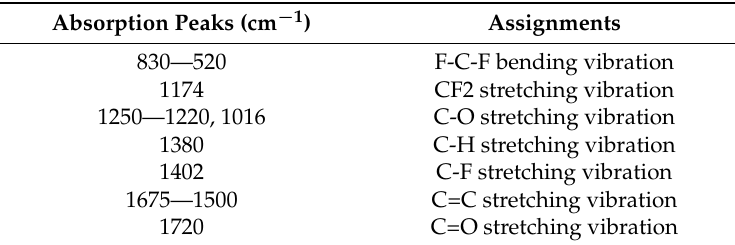
Table 1. Characteristic infrared (IR) absorption